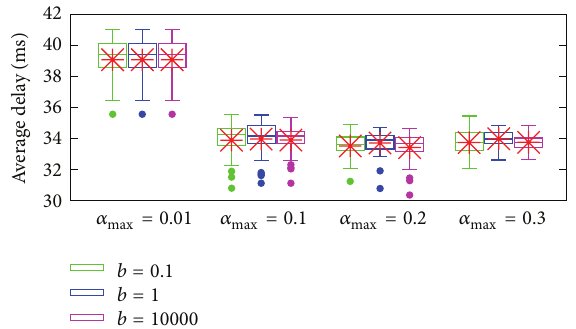
Figure 7: Results of AP+Com with different values of 𝑏